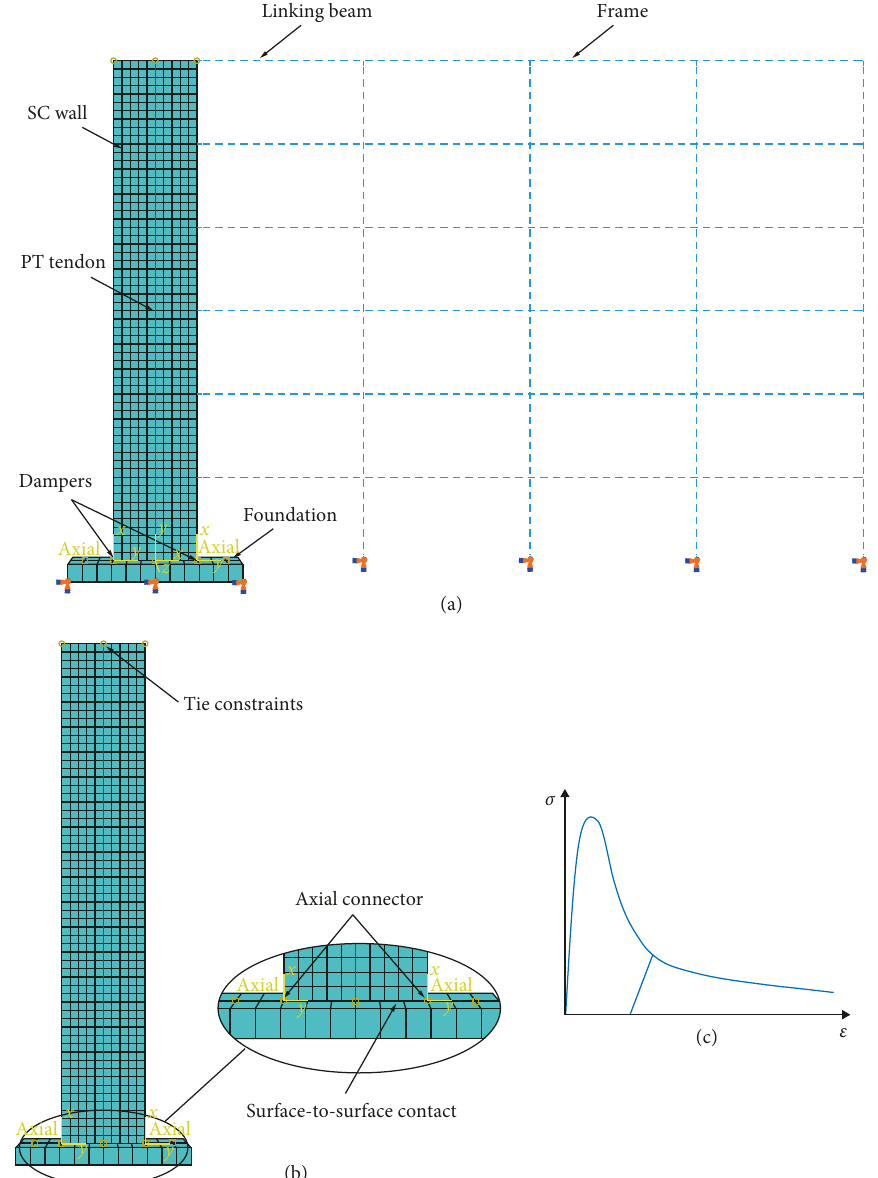
Figure 8: General FE model. (a) Overall FE model. (b) Definition of the interactions. (c) Constitutive relation of the concrete in the frame and linking